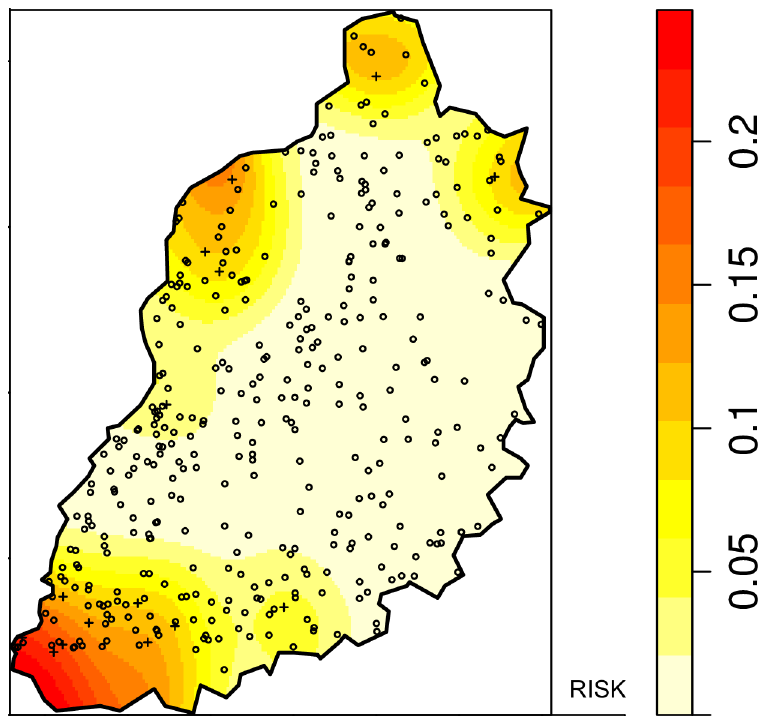
Fig 3. Spatially-smoothed risk map for RVFV seropositivity in the community sample. The points are the locationsof the homesteads.